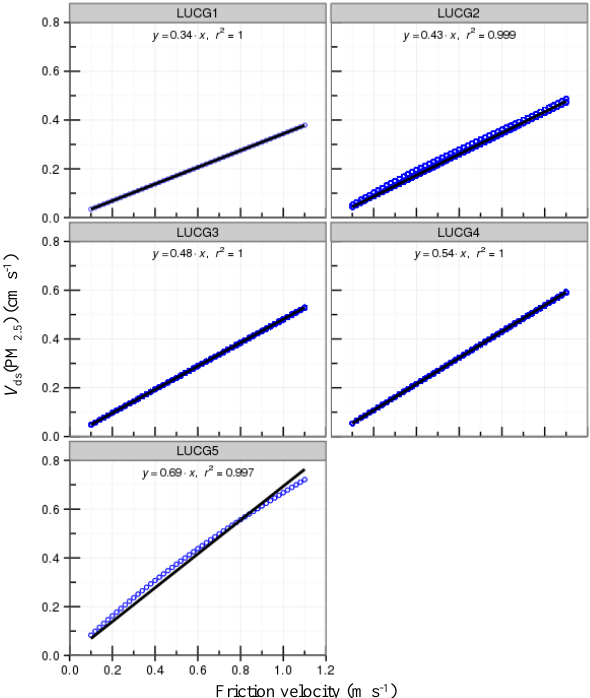
Fig. 1. Bulk V ds (PM 2 . 5 ) as a function of u ∗ for five group LUCs. Solid lines represent regression equations, and circles represent data